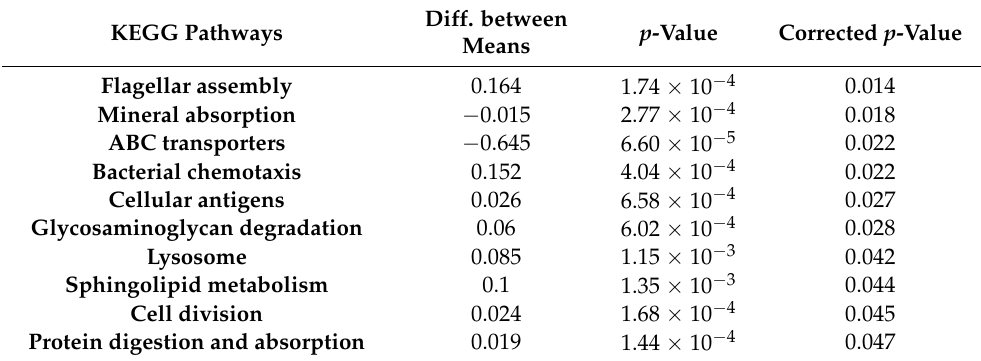
Protein digestion and